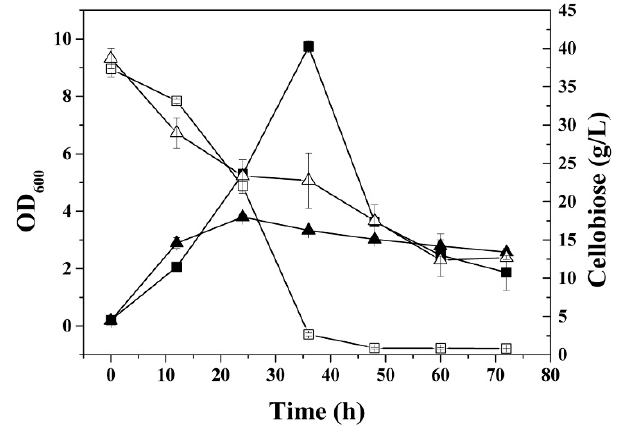
Figure 3. Growth curves and residual cellobiose concentrations of the C. acetobutylicum wild type and the mutant glcCE ::int(193) cultured in minimal medium with cellobiose as the sole carbon source. ( ■ ), OD 600 of wild type; ( ▲ ), OD 600 of glcCE ::int(193) ; ( □ ), residual cellobiose during cultivation of wild type; and ( △ ), residual cellobiose during cultivation of glcCE ::int(193).